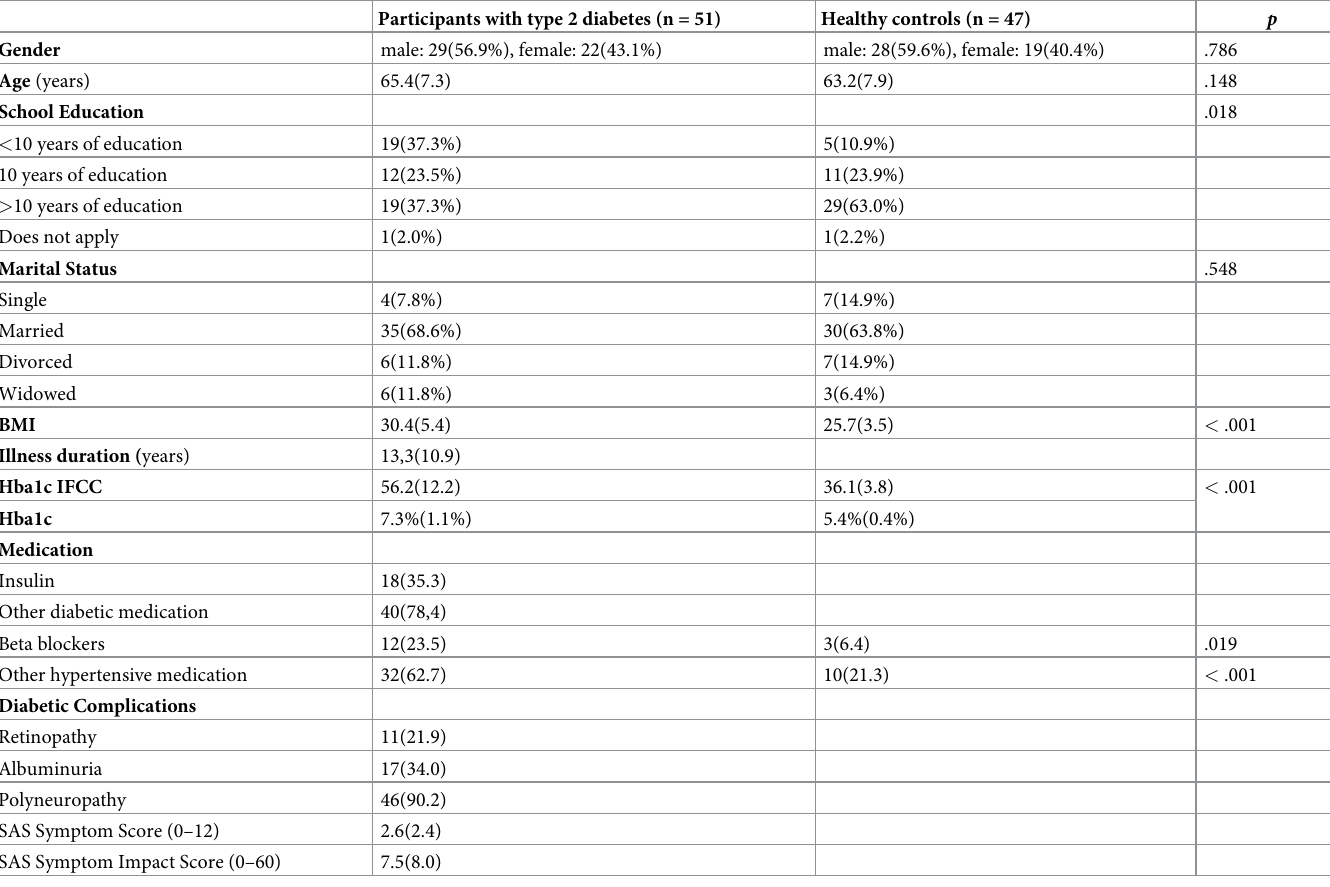
Table 1. Sample description and differences between type 2 diabetes patients and healthy control participants. Data are depicted as means (standard deviation) or n (percentage). Group differences were tested using t -test for continuous variables as well as chi 2 - tests for categorical